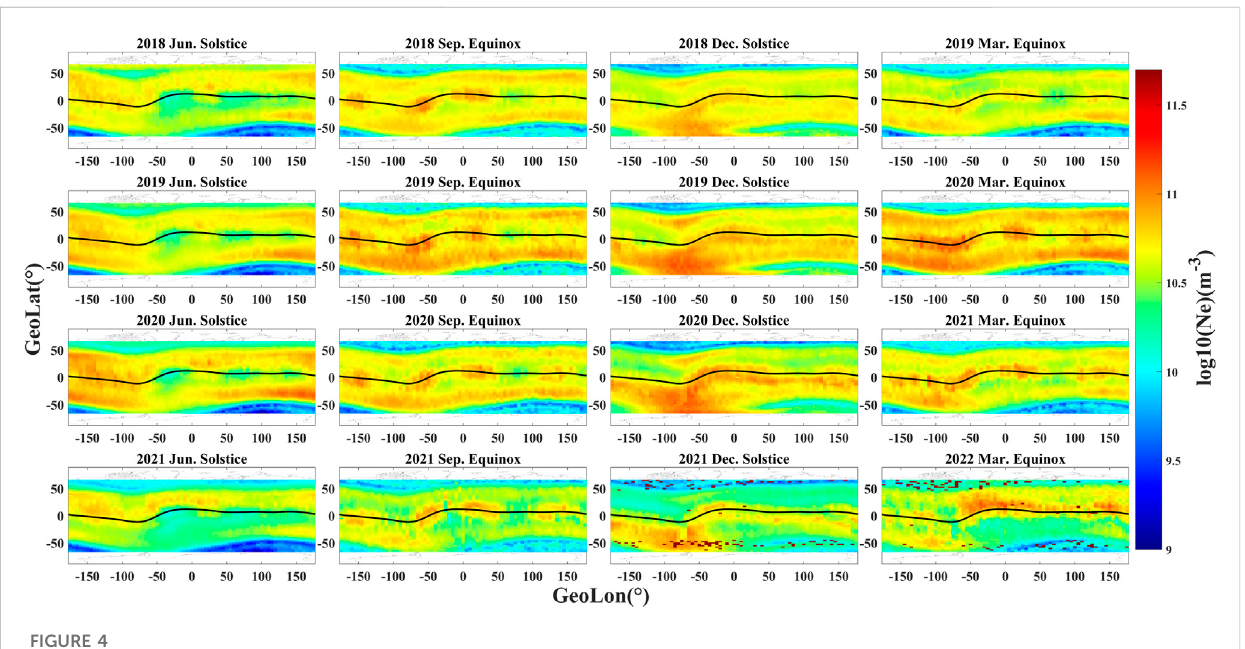
FIGURE 4 Same as Figure 3 but for Ne during